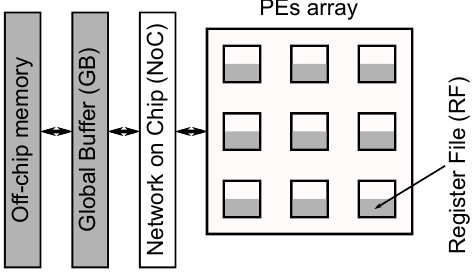
Figure 8. Typical design of an hardware accelerator for